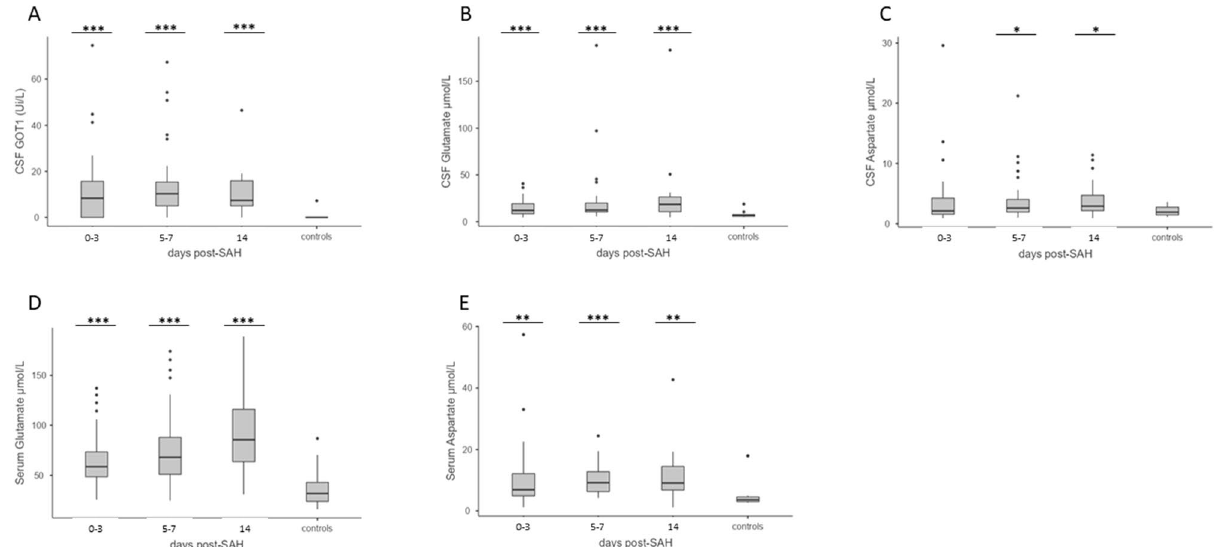
Figure 2. Levels of GOT1, glutamate and aspartate in CSF and serum. Elevated CSF GOT1 level (U/L) on days 0–3, 5–7, and 14 post-SAH versus CSF control samples, obtained from patients affected by benign pituitary pathology ( A ). Elevated CSF glutamate ( B ) and aspartate ( C ) levels on days 0–3, 5–7, and 14 post-SAH versus CSF control samples obtained from patients affected by benign pituitary pathology Data are shown as mean ± SD. Statistical analysis was performed using the two-tailed Student’s t -test. *** p < 0.001.. Elevated serum glutamate ( D ) and aspartate ( E ) levels on days 0–3, 5–7, and 14 post-SAH versus blood control samples of healthy volunteers. Data are shown as mean ± SD. Statistical analysis was performed using the Mann Whitney test. * p < 0.05, ** p < 0.01, *** p <